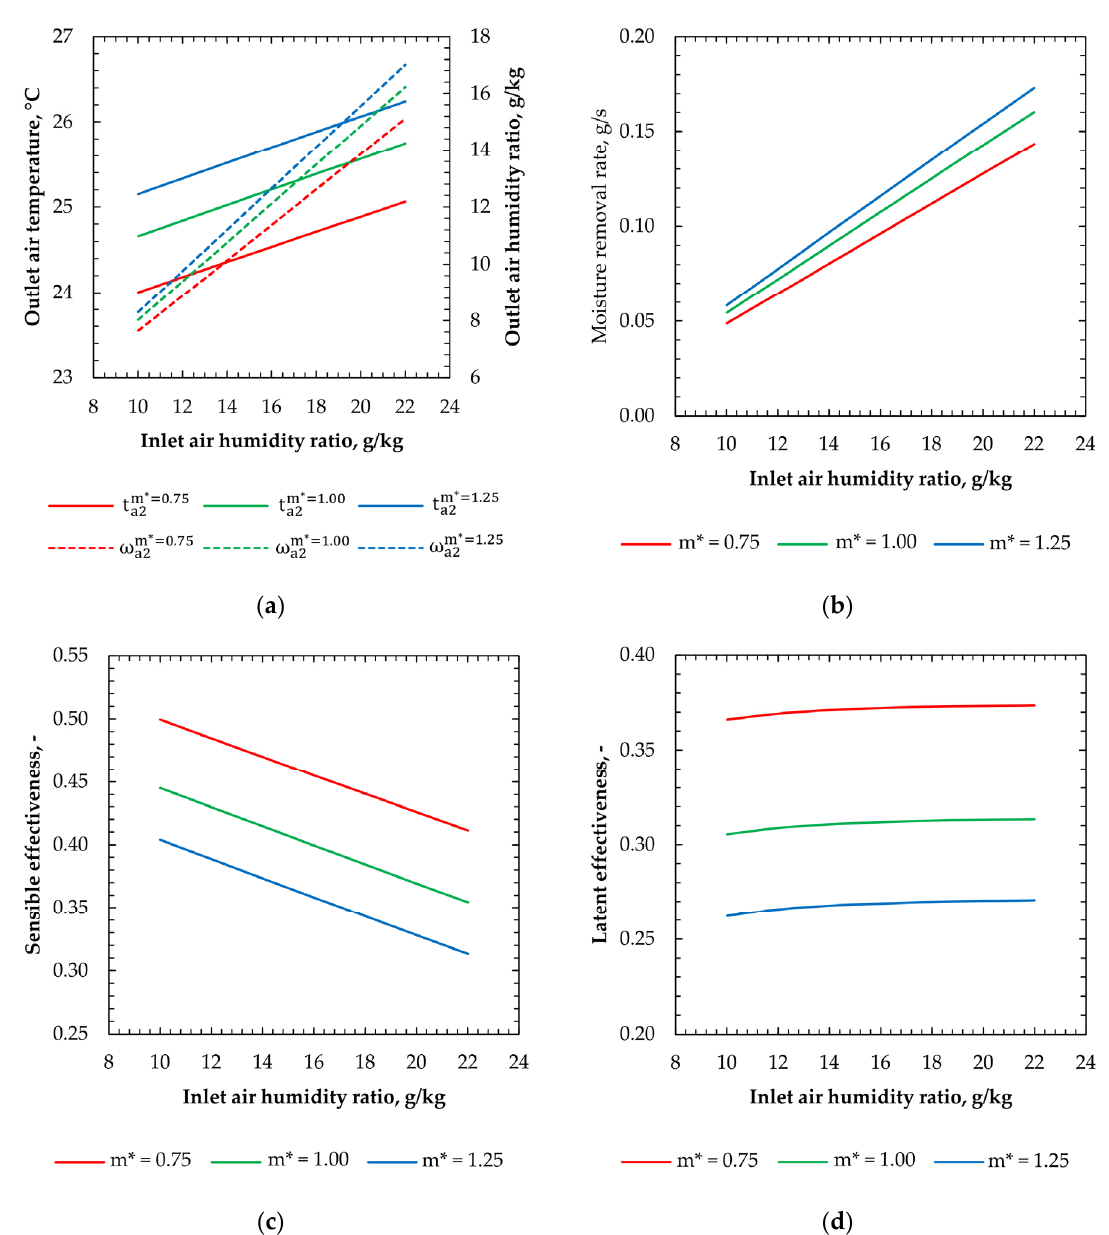
Figure 7. Effect of inlet air-humidity ratio in regard to different air to solution mass flow ratios: ( a ) on outlet air temperature and outlet air-humidity ratio; ( b ) on moisture removal rate; ( c ) on sensible effectiveness; ( d ) on latent effectiveness.